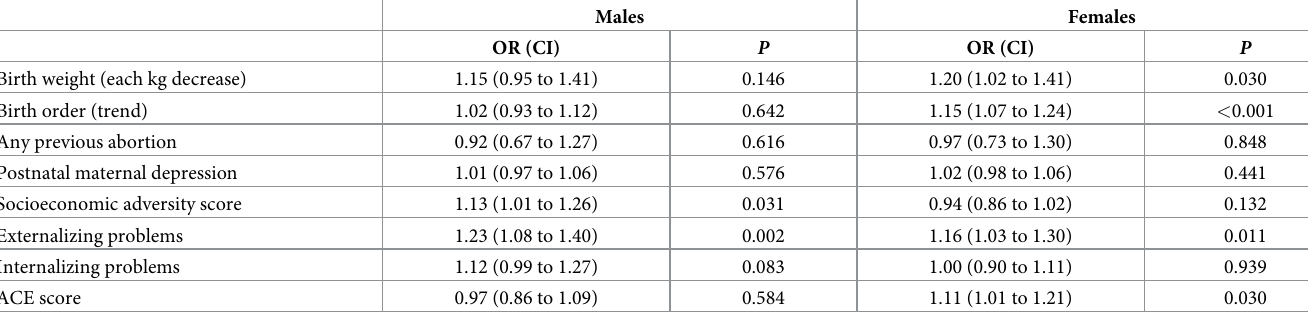
Table 4. Multivariable associations between childhood factors and suicidal